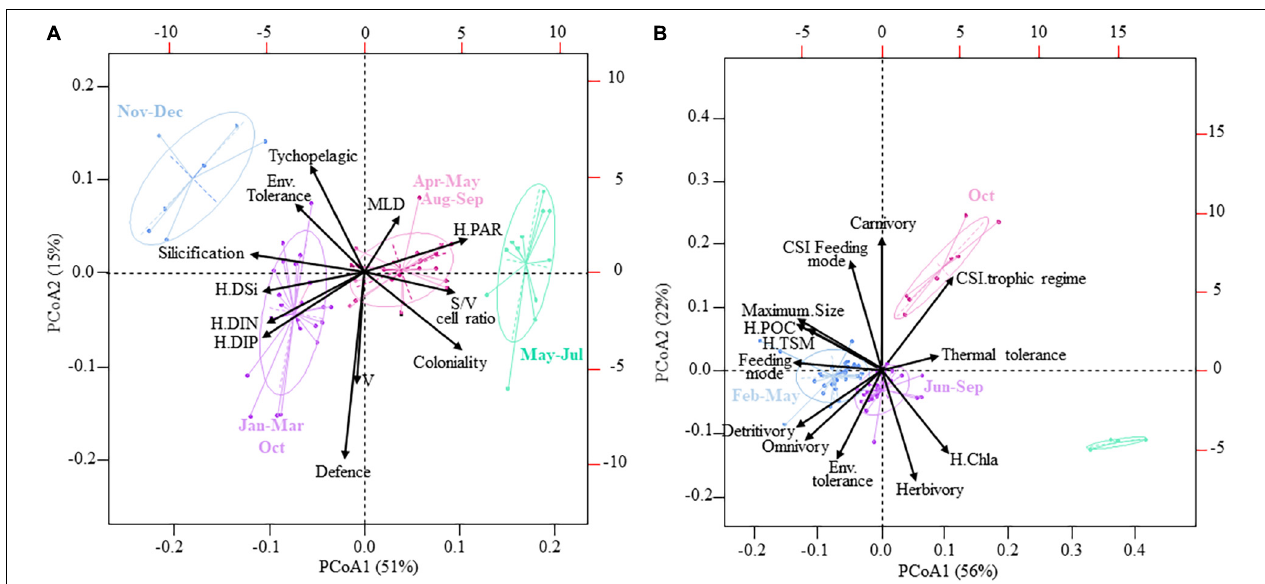
FIGURE 4 | Principal coordinates analysis (PCoA) of the functional structure and ecological specialization of the (A) diatom and (B) copepod community in coastal waters of the eastern English Channel over the period 2007–2013. The percentage of the total variance explained by each axis is shown in parentheses. Months are grouped together following the results of a Hierarchical Agglomerative Clustering (HAC) using the Ward’s linkage and the two first coordinates of the PCoA. Each point represents a monthly averaged community sample. The ellipses show a 95% confidence level. H, niche breadth; PAR, Photosynthetic Active Radiation; DIN, DIP, DSi, Dissolved Inorganic Nitrogen and Phosphorous, and Silica; Chla, Chlorophyll a ; S/V cell ratio, Surface to Volume cell ratio; MLD, Maximum Linear Dimension; Env. Tolerance, environmental tolerance; CSI, Community Specialization Index; TSM, Total Suspended Matter; POC, Particulate Organic Carbon. Thermal tolerance in panel (A) is not shown given its central position on the PCoA